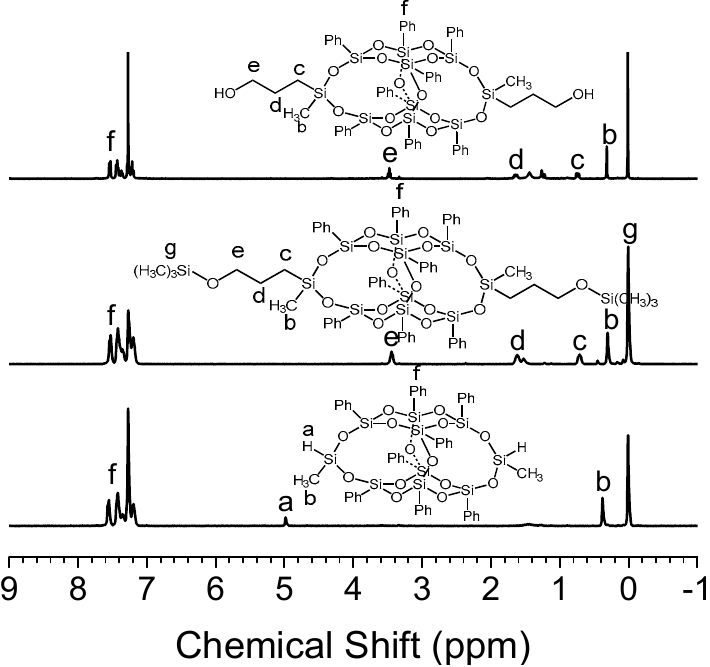
Figure 2. 1 H-NMR spectra of 3,13-dihydroxypropyloctaphenyl B-POSS (B-POSS), 3,13-di(trimethylsilyl) oxypropyloctaphenyl B-POSS and 3,13-dihydrooctaphenyl B-POSS from top to